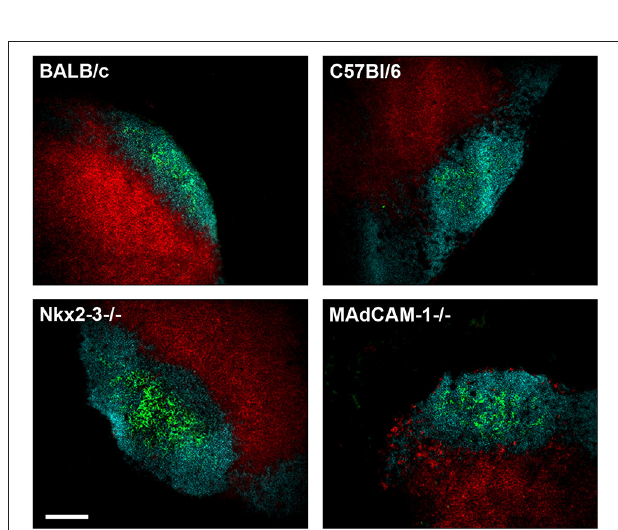
FIGURE 5 | Preserved structure of pLN in the absence of MAdCAM-1. Cryostat sections from inguinal lymph nodes of 6 weeks old Nkx2-3 − / − , Nkx2-3 + / − , MAdCAM-1 − / − , and C57BL/6 mice were stained for B cells (B220/turquoise), T cells (Thy-1/red), and follicular dendritic cells (CD21/35/green) as indicated (scale bar: 100 µ m. Representative image, the staining was repeated